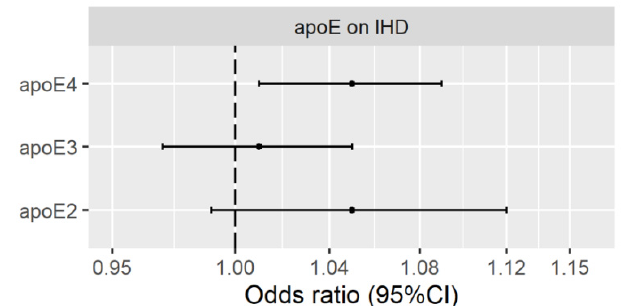
Figure 1. Univariable MR estimates for plasma apolipoprotein E2 (apoE2), apolipoprotein E3 (apoE3) and apolipoprotein E4 (apoE4) on ischemic heart disease (IHD) using inverse variance weighting with genetic predictors from the KORA